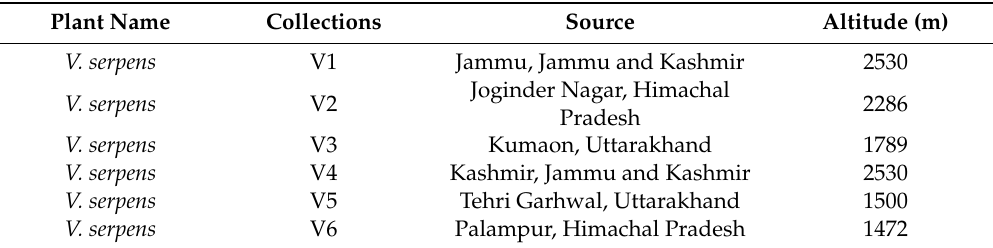
Table 4. Sources of Viola